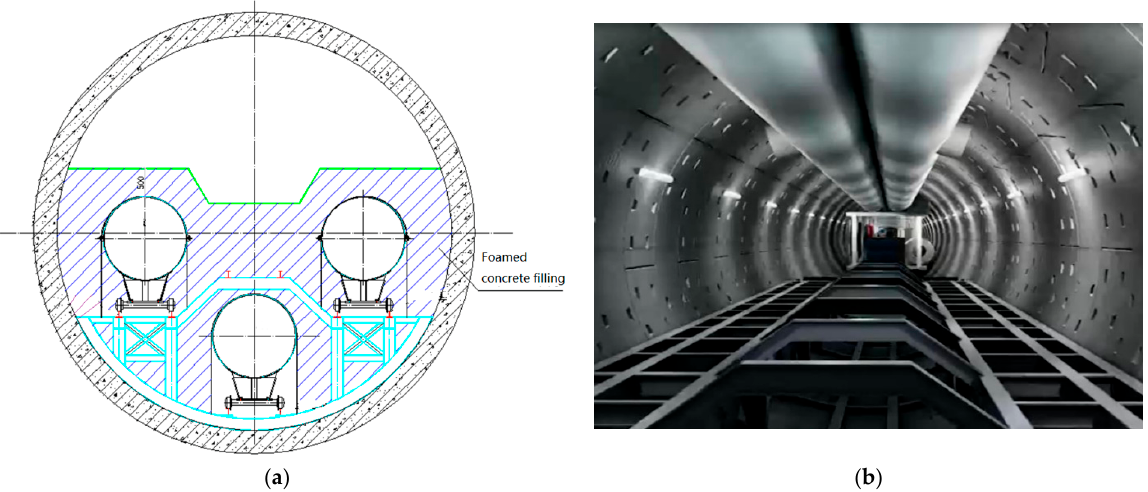
Figure 2. Schematic diagram of foamed concrete tunnel filling: ( a ) sectional structure diagram; ( b ) diagram of the tunnel interior.